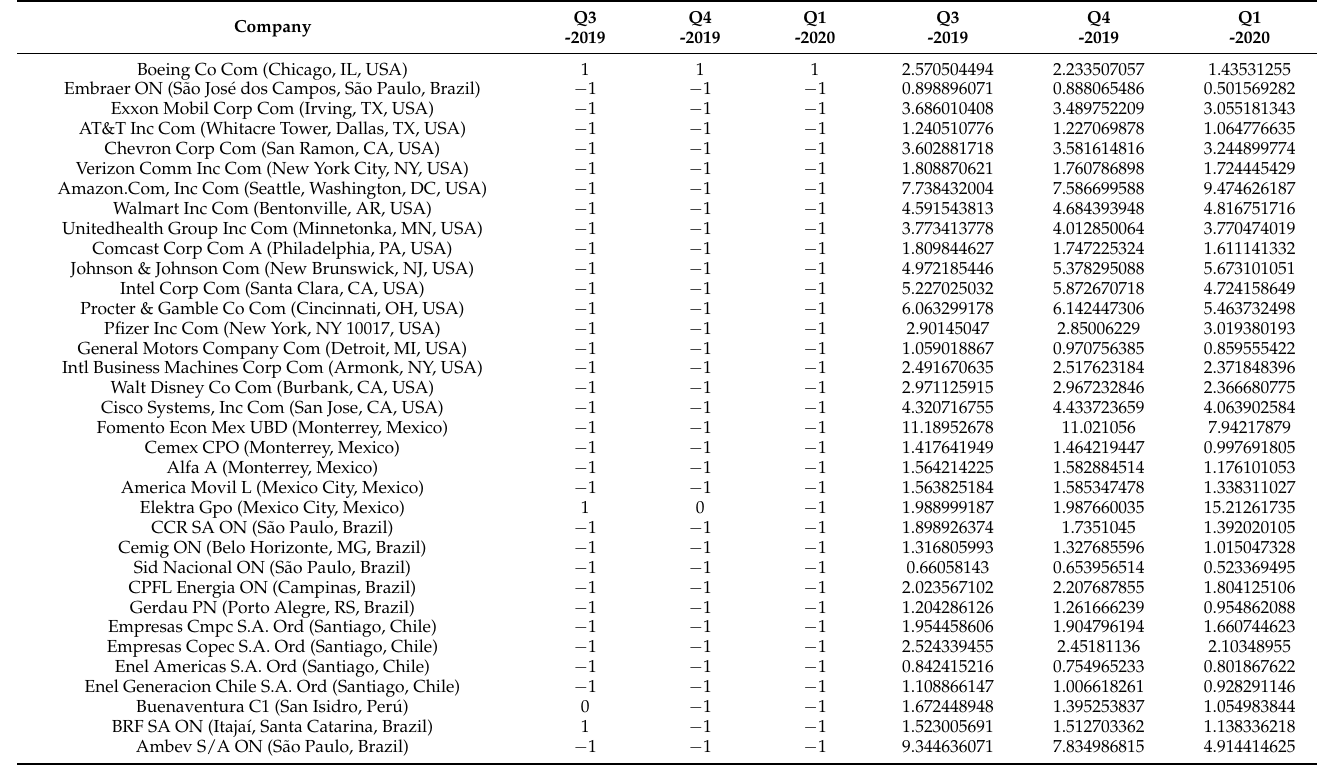
Table 5. Z Altman vs. Minsky’s Groups. 1 March 2014 to 1 March 2020.